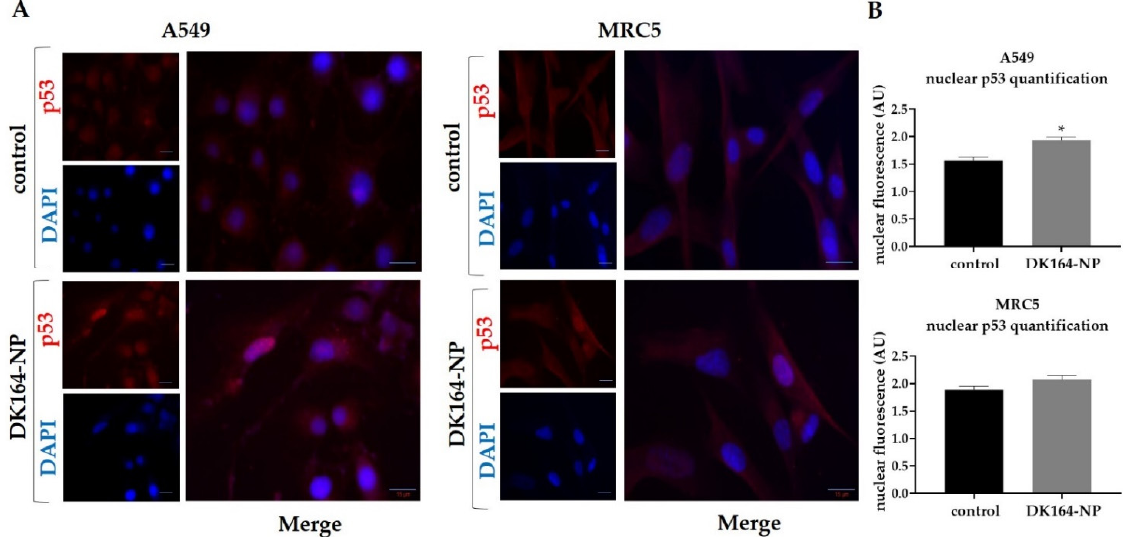
Figure 7. Activation and nuclear translocation of the p53 protein in A549 and MRC5 cells. ( A ) Representative immunofluorescence images of A549 and MRC5 control cells and cells treated with the calculated IC50 concentrations of DK164-NP for 48 h and labeled with anti-p53 antibody (red). DNA was co-stained with DAPI (blue); ( B ) Quantitative determination of the intensity of the nuclear p53-signal, normalized with nuclear DNA content, was performed by CellProfiler cell image analysis software (Broad Institute’s Imaging Platform, Cambridge, MA, USA) and GraphPad Prism 8.0 (Dotmatics, San Diego, CA, USA). A p -value < 0.05 was considered statistically significant, * p < 0.05. Quantification is based on three independent experiments with >50 cells scored for each condition. Error bars represent standard deviation (SD); AU: arbitrary unit. Scale bars represent a distance of 15 µm.